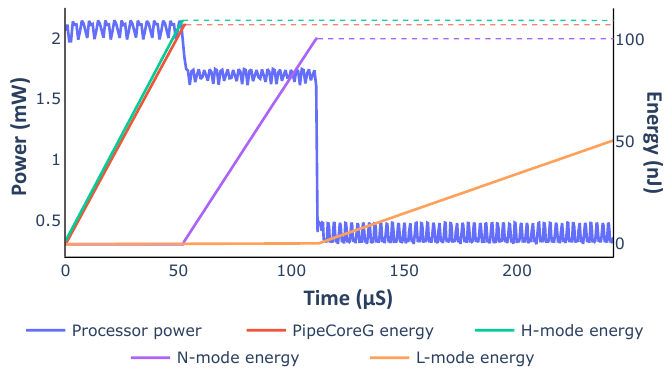
Figure 14. Dynamic power and energy for